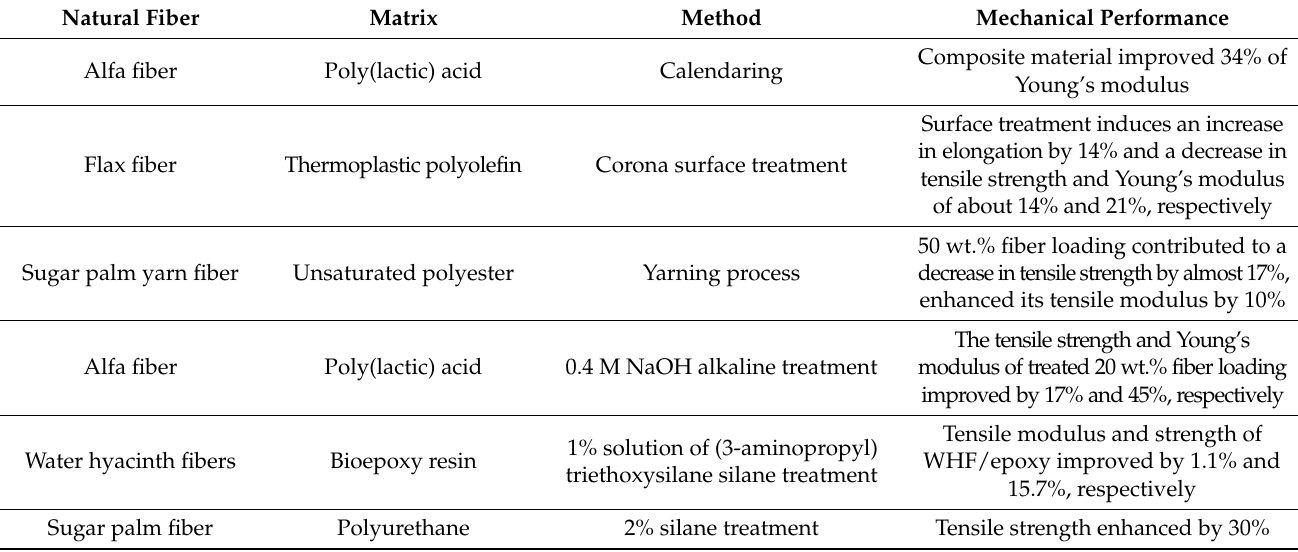
Table 1. Some treatments of natural fiber reinforced biocomposites. Adapted from Nurazzi et al. [15]. Natural Fiber Matrix